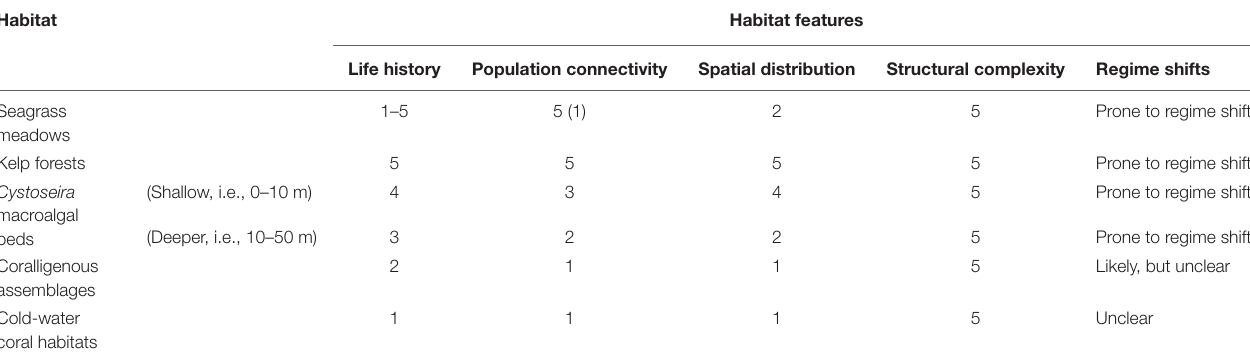
TABLE 3 | The agreed-on expert scoring of the habitat features according to their contribution to the successful accomplishment of habitat restoration; 1 – low contribution, 5 – high contribution.